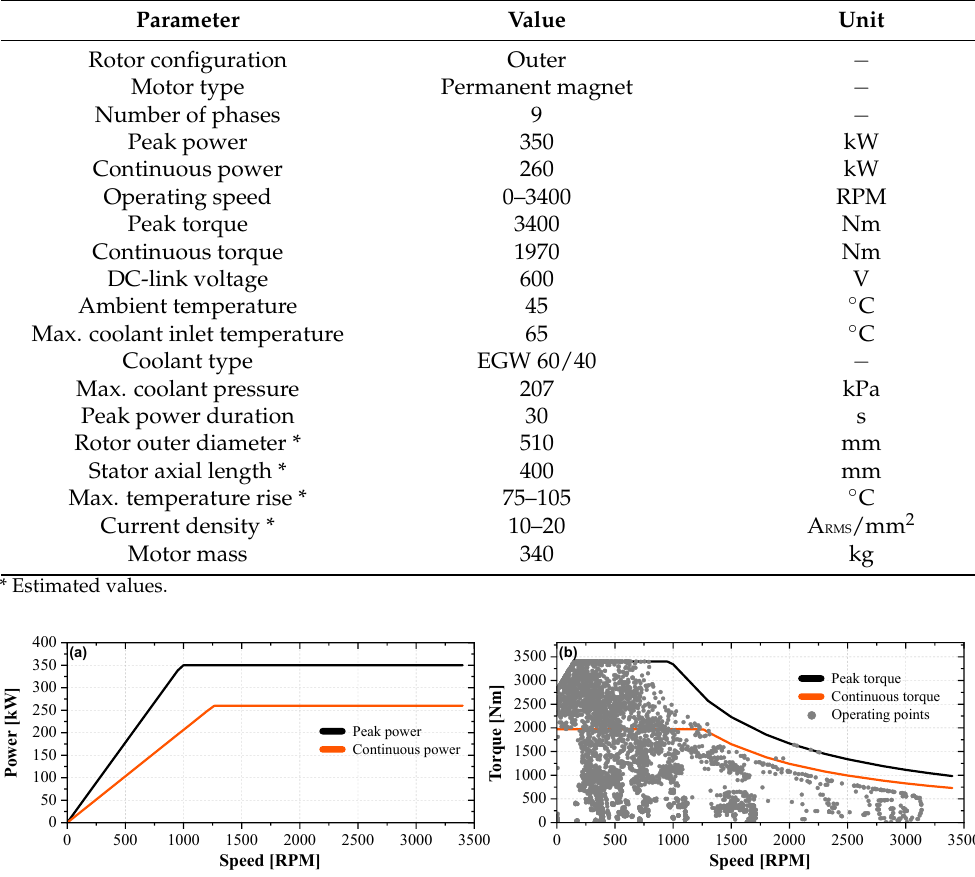
Figure 1. TM4 SUMO HD HV3500-9P performance characteristics: ( a ) power–speed curve and ( b ) torque–speed